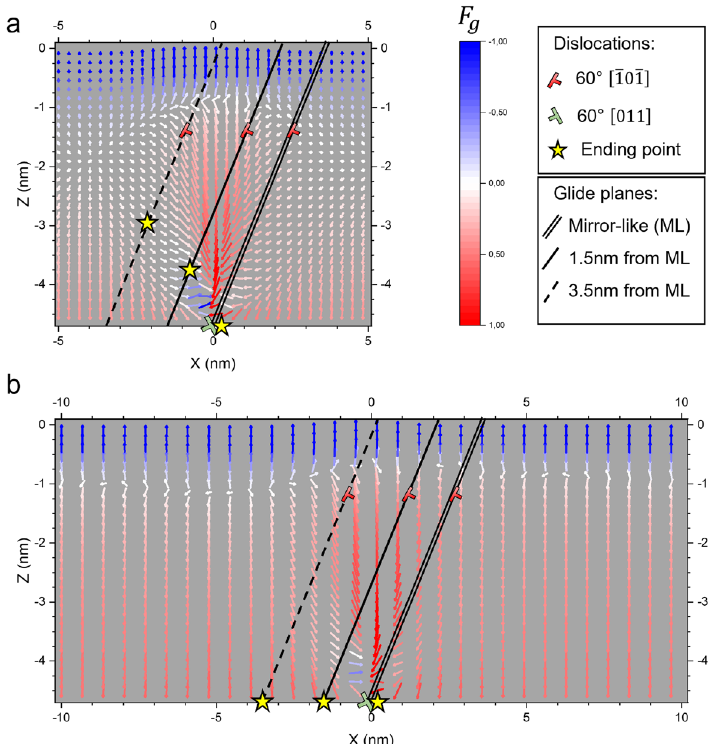
Figure 2. Map of the Peach and Koehler force acting on dislocation “B” with Burgers vector � b = a / 2 [¯ 10 ¯ 1 ] as a function of its position in a Ge film. The complementary dislocation “A” with Burgers vector � b = a / 2 [ 011 ] is fixed at the interface in x = 0 . The total (i.e., glide and climb together) force vectors are colored in blue-red scale to represent the projection of the Peach and Koehler force along the glide plane. Black lines are inserted to show some possible glide planes of dislocation “B”: double line—mirror-like glide plane, solid line—glide plane at d ML = 1.5 nm , dashed line—glide plane at d ML = 3.5 nm . For each glide plane, a star indicates the